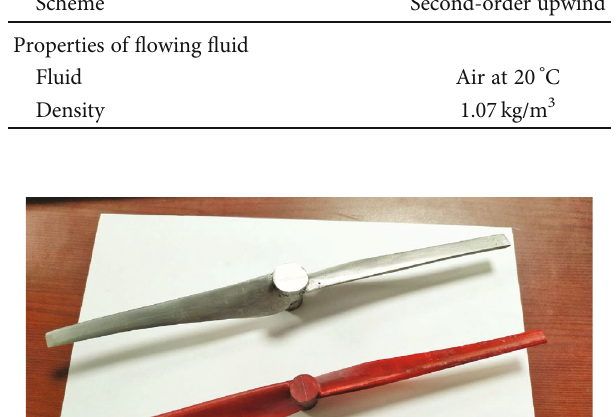
Table 4: Comparison of thrust